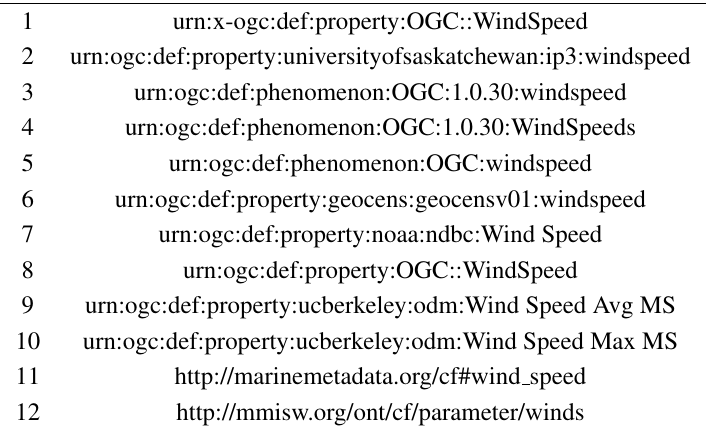
Table 1. Various observed properties of the concept of wind